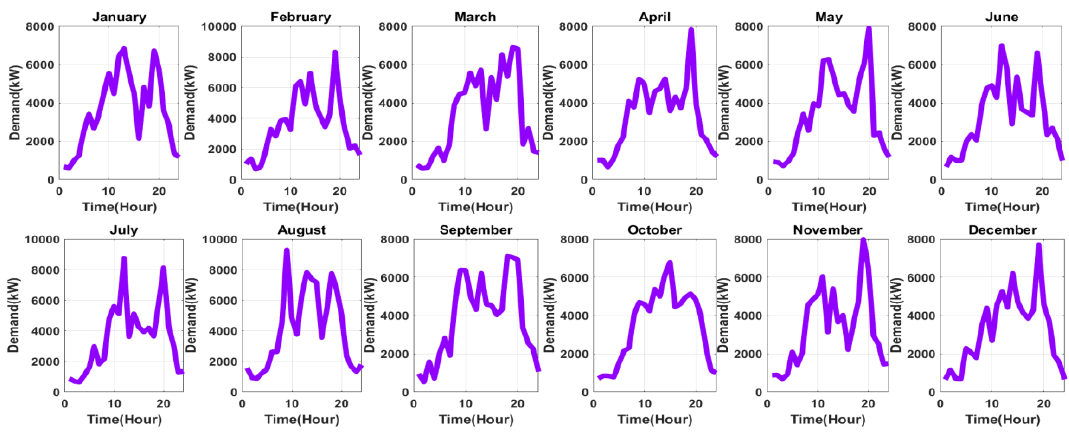
Figure 5. Electricity demand.